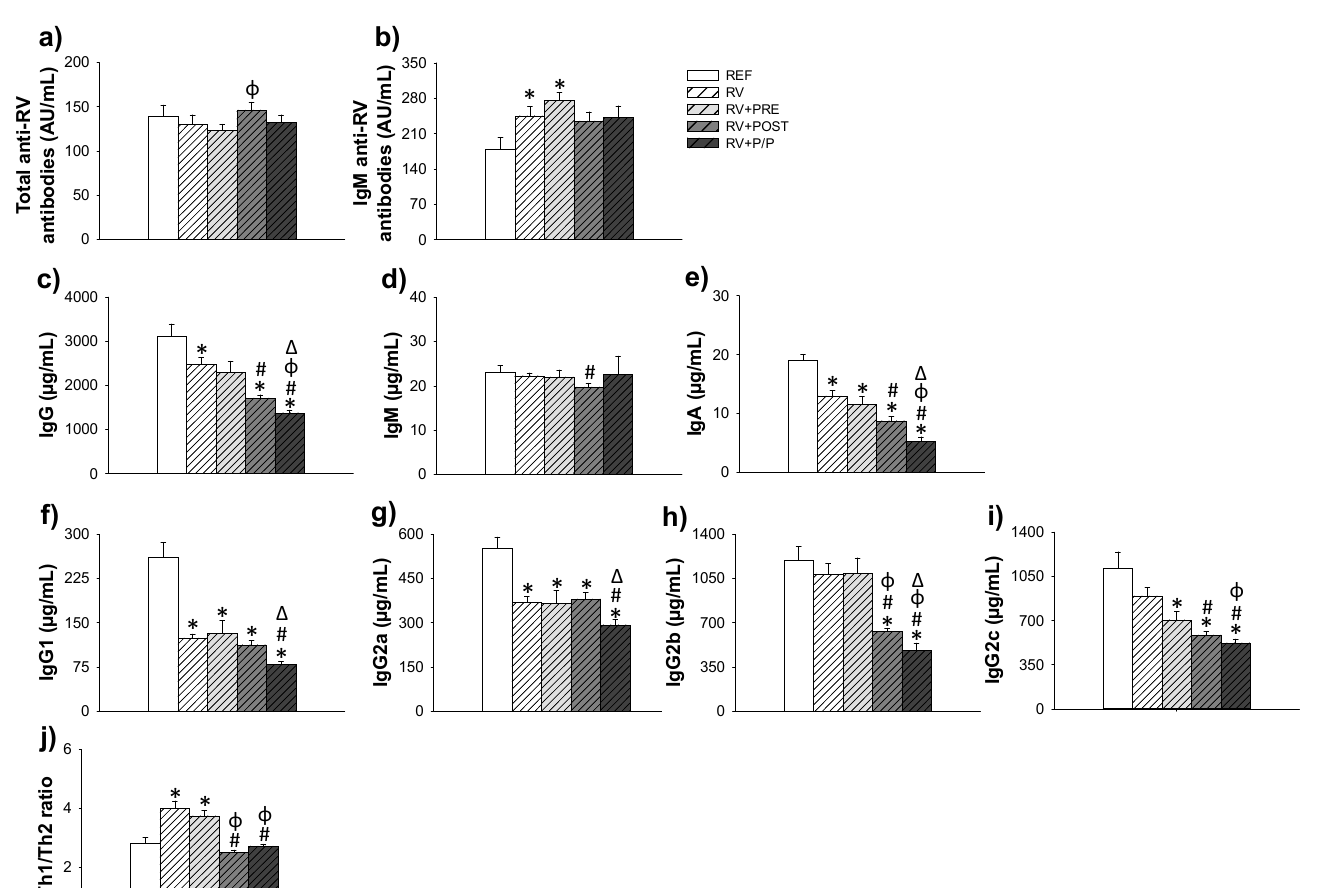
Figure 6. Concentration of total anti-RV antibodies ( a ), IgM anti-RV ( b ), and immunoglobulins in plasma ( c )–( i ) at the end of the study (day 16). Th1/Th2 ratio refers to the relationship between IgG2b + IgG2c and IgG1 + IgG2a ( j ). Results are expressed as mean ± SEM ( n = 12). Statistical differences: * vs. REF, # vs. RV, ϕ vs. RV + PRE, Δ vs. RV + POST. REF: reference group; RV: rotavirus group; RV + PRE: rotavirus group supplemented with a mixture of scGOS/lcFOS; RV + POST: rotavirus group supplemented with Lactofidus TM ; RV + P/P: rotavirus group supplemented with the combination of